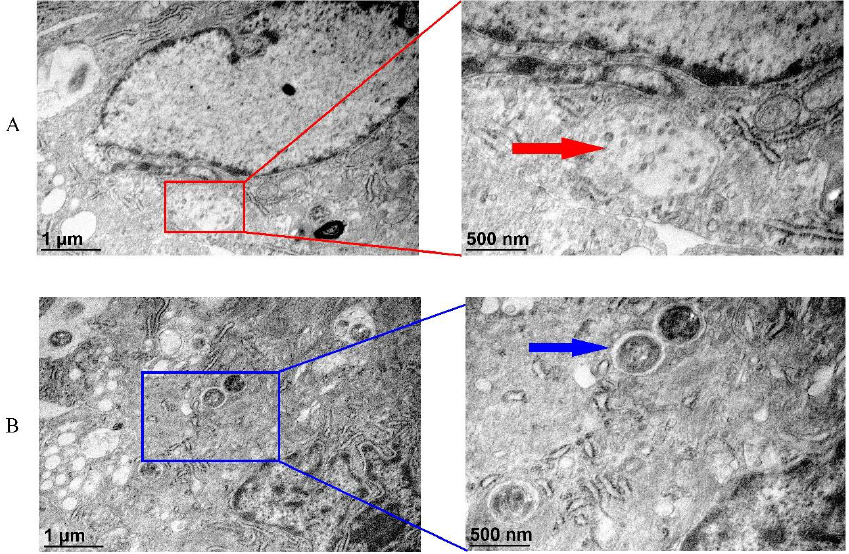
Figure 7. Transmission electron micrograph of TA-11 infected by CGSIV: ( A ) areas indicated by red arrows containing virus particles; ( B ) transmission electron micrograph of TA-11-infected S. agalactiae . The areas indicated by blue arrows contain bacteria.